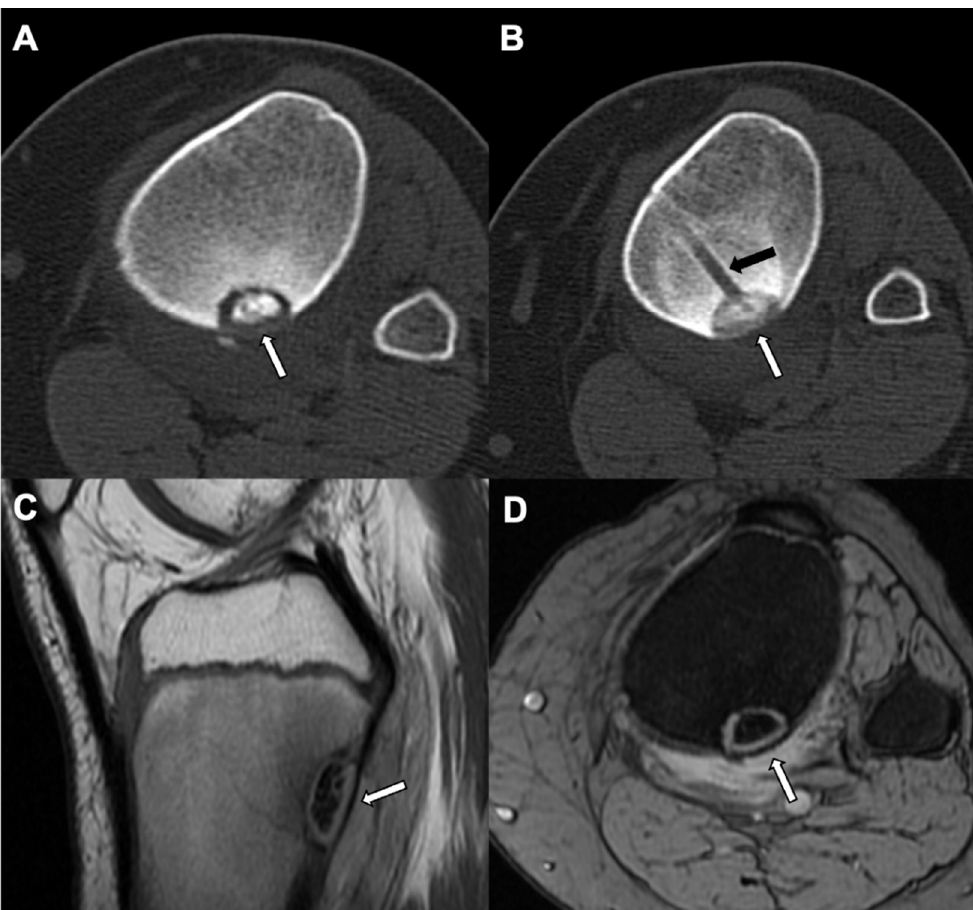
Figure 6. Osteoid osteoma with RF ablation: Left leg CT bone window axial view ( A ) in a 13-year-old patient shows well defined sclerosis with surrounding lytic margin along the posterior tibial cortex (white arrow), suggesting an osteoid osteoma. Status post RF ablation of the same lesion ( B ) showed developing minimal scattered sclerosis in lytic component (white arrow) with an ablation track (black arrow). MRI left leg sagittal T1 ( C ) and axial proton density image ( D ) of the same patient shows diffuse ring sign which is identified as central hypointense area surrounded by peripheral hyperintense area, suggesting favorable response to ablation (white arrows).